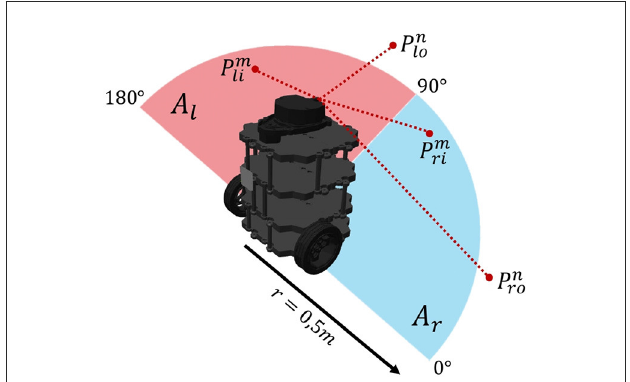
FIGURE10 Signal processing. Take l for left and r for right. Take i for inside and o for outside.